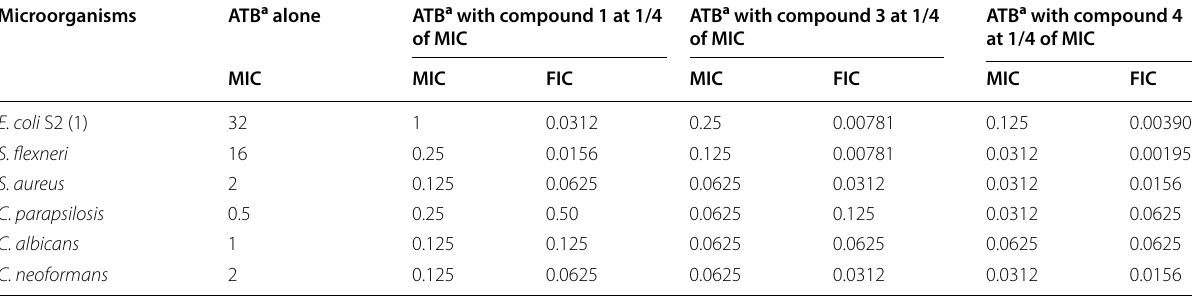
MIC minimal inhibitory concentration, FIC fractional inhibitory concentration, ATB antibiotics a Fluconazole for yeasts and tetracycline for bacteria; compounds 1 , 3 and 4 were tested at the concentration of MIC/4 on the corresponding microorganism Table 4 Fractional inhibitory concentrations (FIC) calculated for the combination of reference antibiotics and compounds 1, 3 and 4 as a function of